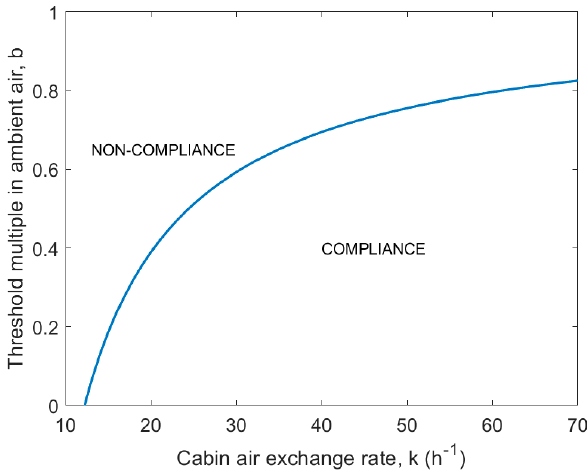
Figure 4. H&S standard compliance in cabin air with respect to CO 2 .